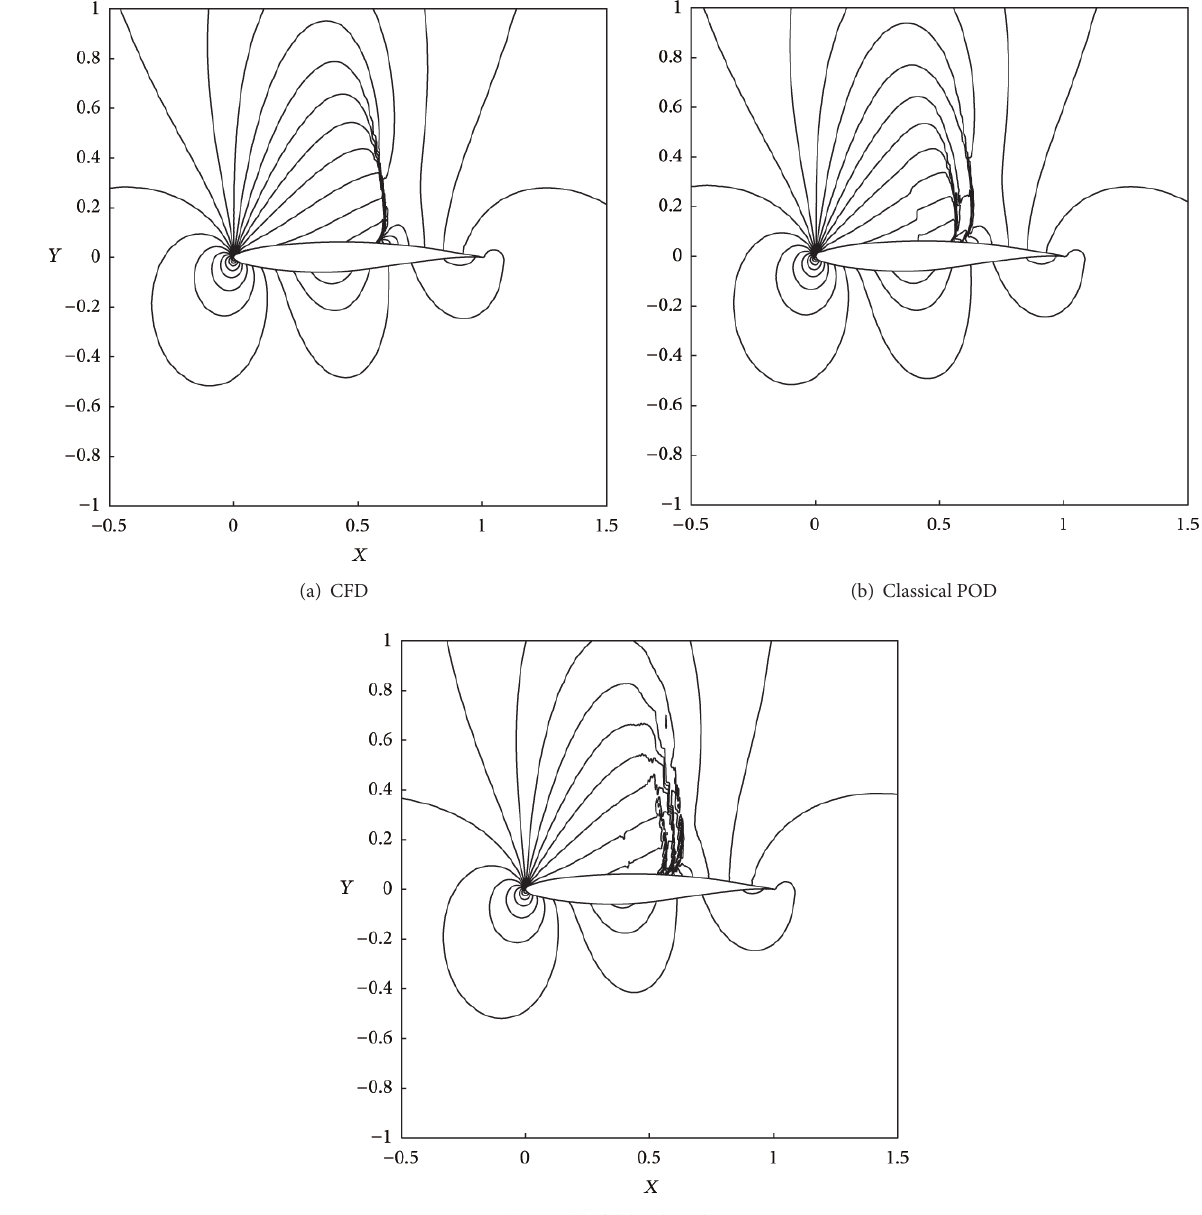
Figure 8: Comparison of the 3 contours of pressure at Mach = 0.7375 and A . O . A . = 3.375